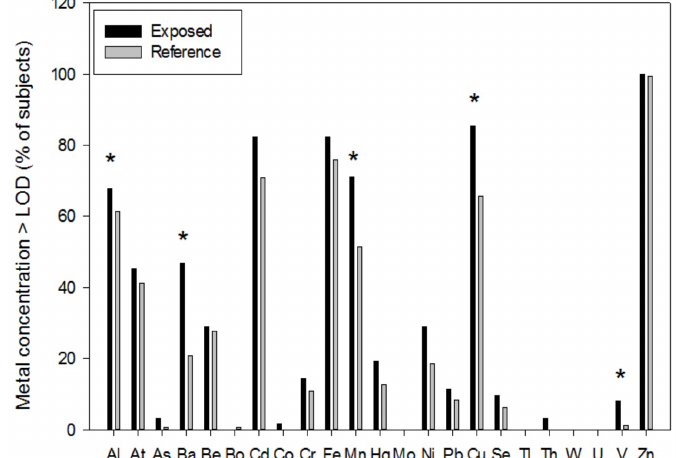
Figure 2. Proportion of children with metal concentration in toenails above the limit of detection (LOD). Children living within a 3 km radius from the two incinerators were considered exposed (n = 62). Children in the reference area (n = 158) were those living in the remaining city areas. Asterisks indicate p < 0.01 (chi-squared